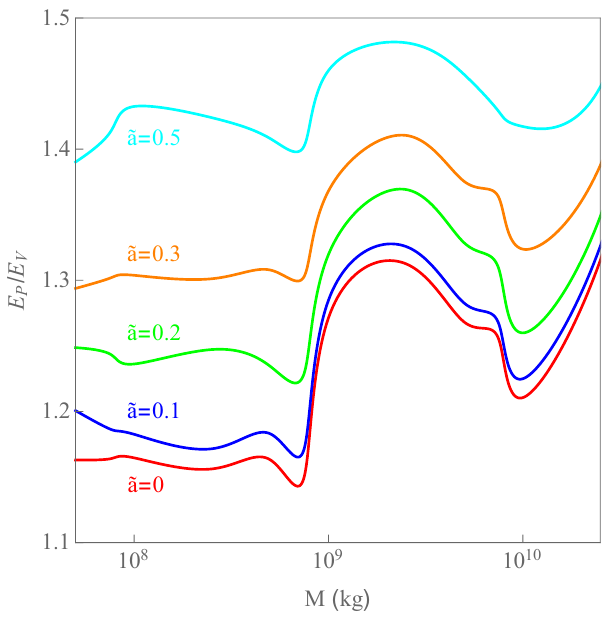
Figure 9 . Ratio E P /E V as a function of the PBH mass computed with BlackHawk/PYTHIA, for ˜ a = 0 , 0 . 1 , 0 . 2 , 0 . 3 , 0 . 5 (red, blue, green, orange, cyan,